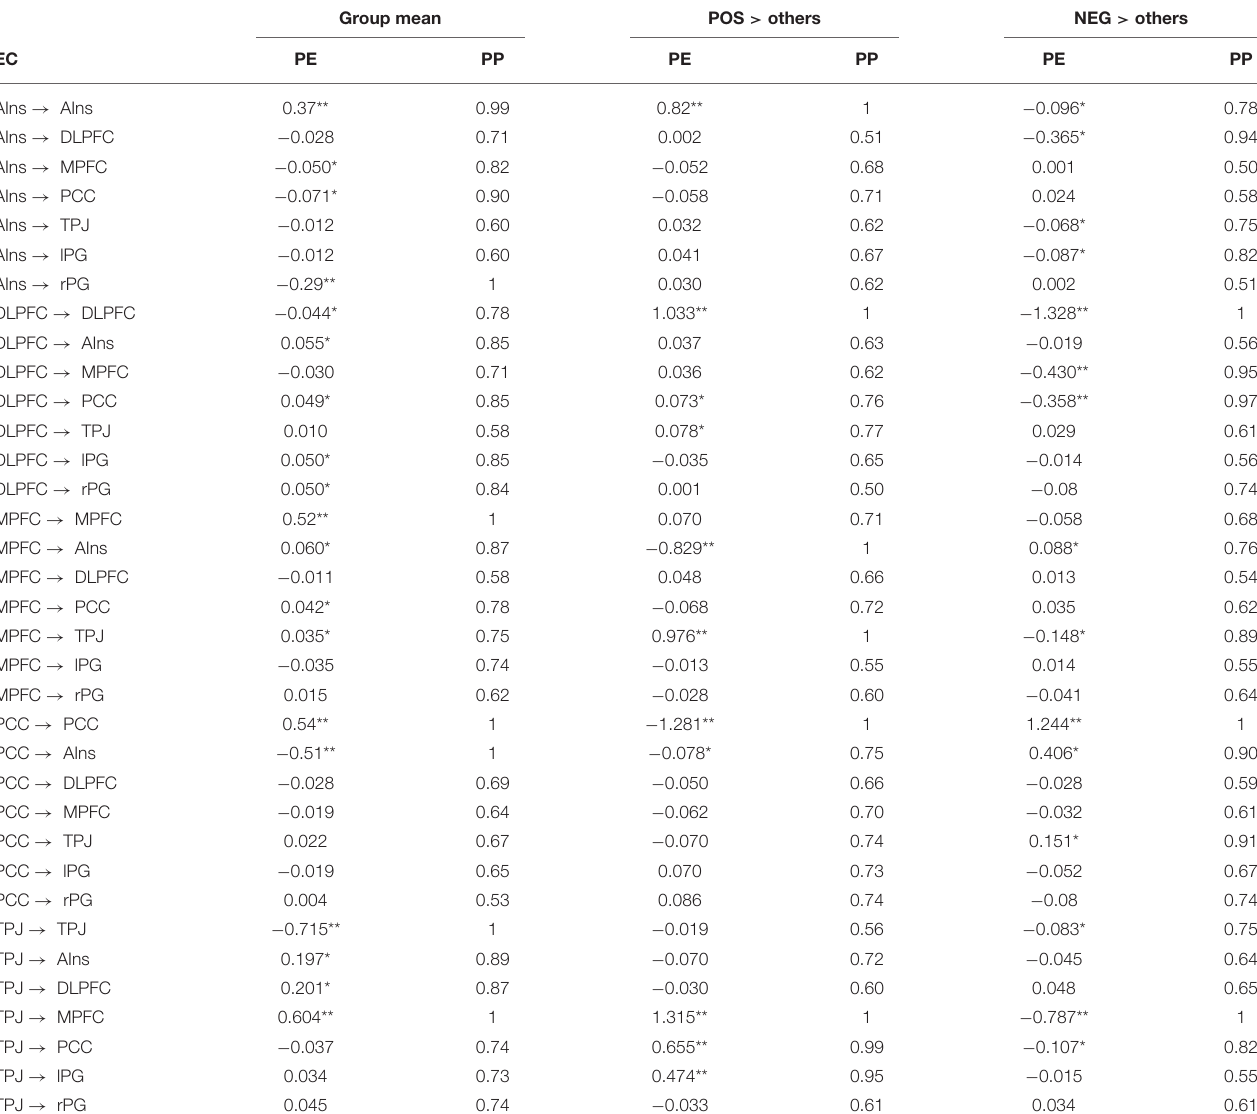
TABLE 2 | Results of DCM PEB analyses. Group mean POS > others NEG >